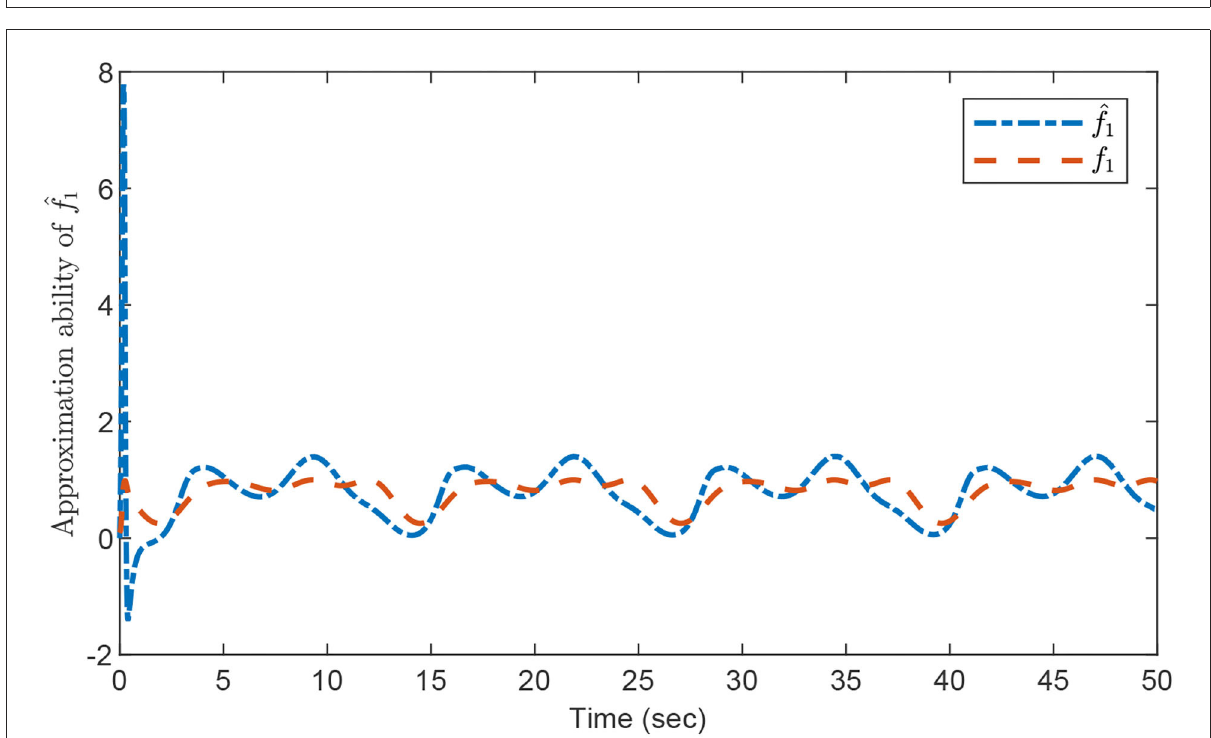
FIGURE3 Approximation ability of ˆ f 1 by using composite learning adaptive